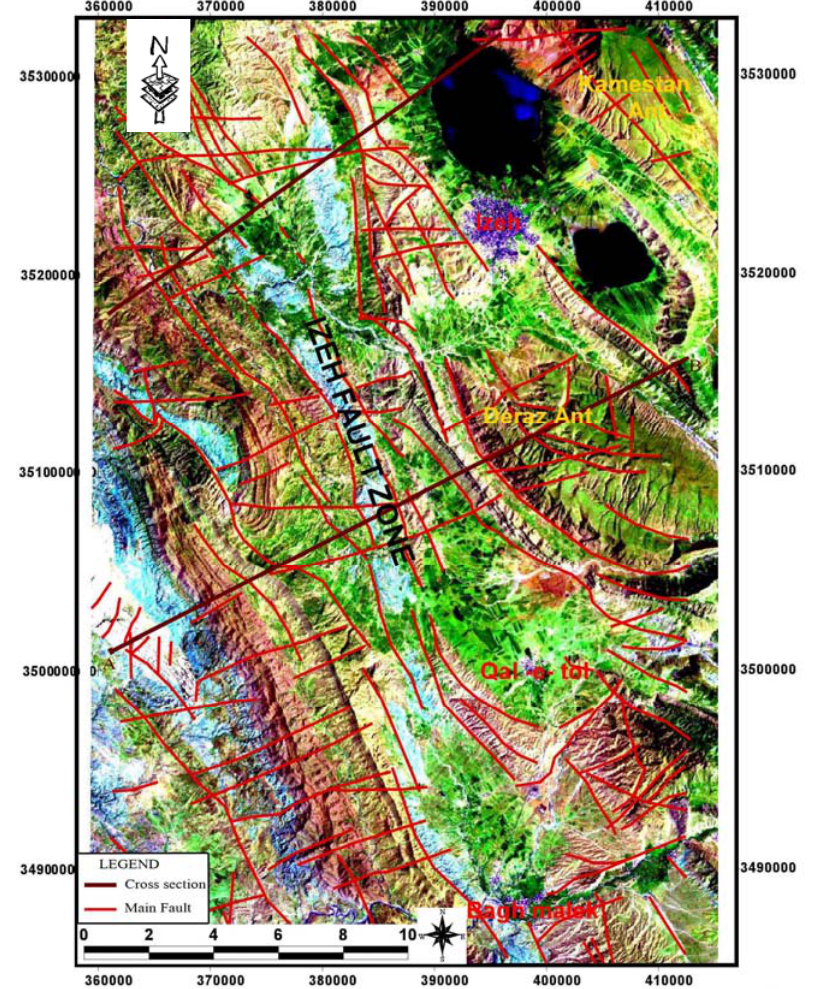
Figure 2. The study area with structural features and AB cross section on ETM+ image with FCC